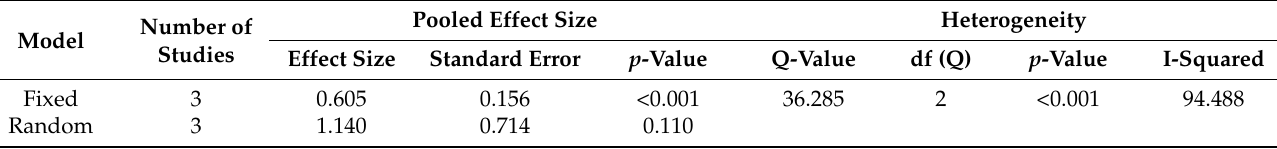
Table 11. Heterogeneity test results of studies on the influence of indoor plants on EEG α waves.